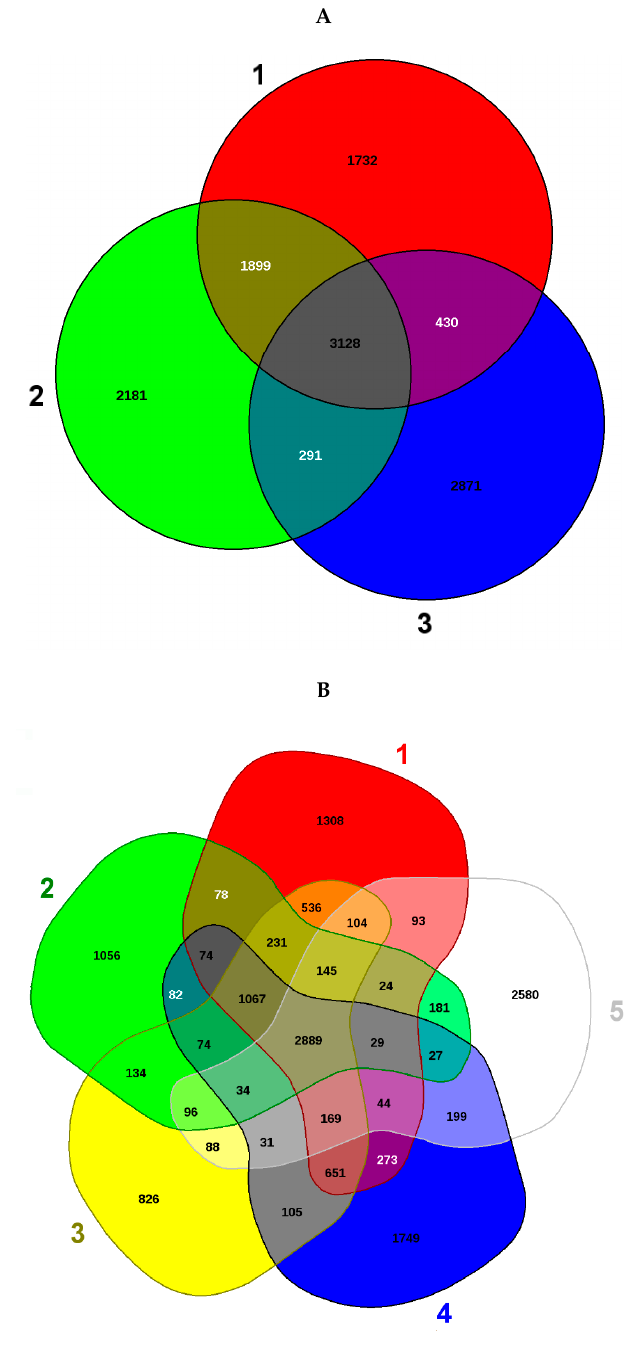
Figure 4. Shown are the whole-genome sequence-based Venn diagrams generated by the EDGAR pipeline revealing strains SRS-25 and 46 along with a previously isolated strain from our research ( Burkholderia sp. strain SRS-W-2-2016). These isolates share a common pool of 3128 genes ( A );